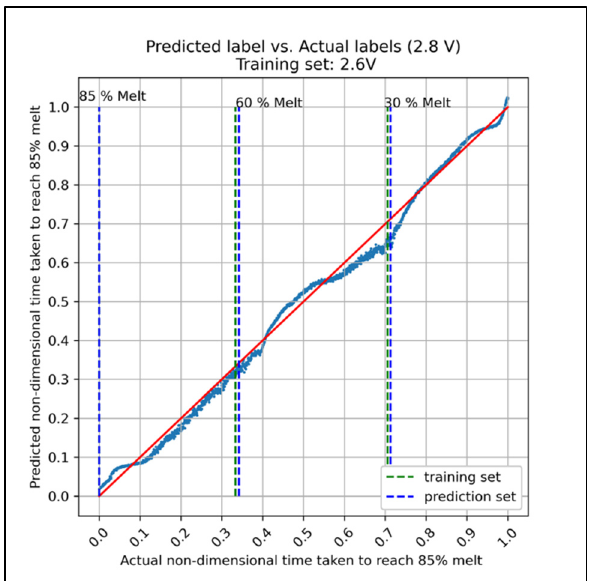
Figure 11. Scatter plot comparing the ANN predictions with experimental data (the actual values for τ ’ ) for test data set of 2.8 V (training data set of 2.6 V).